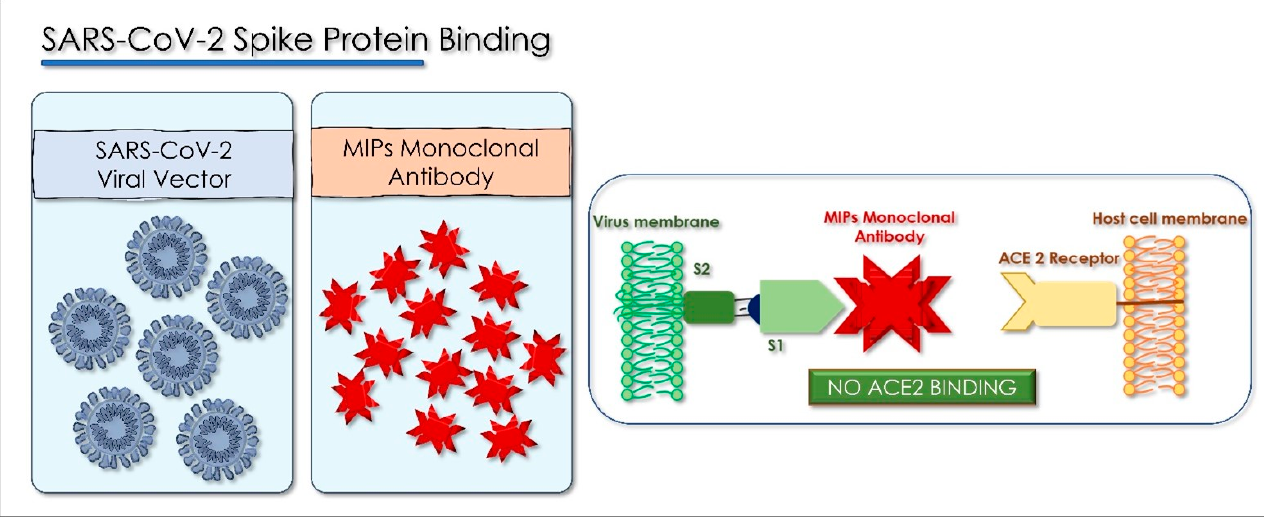
Figure 6. Monoclonal Antibody (MIPs) mechanisms against the SARS-CoV-2 S protein binding with the host cells.